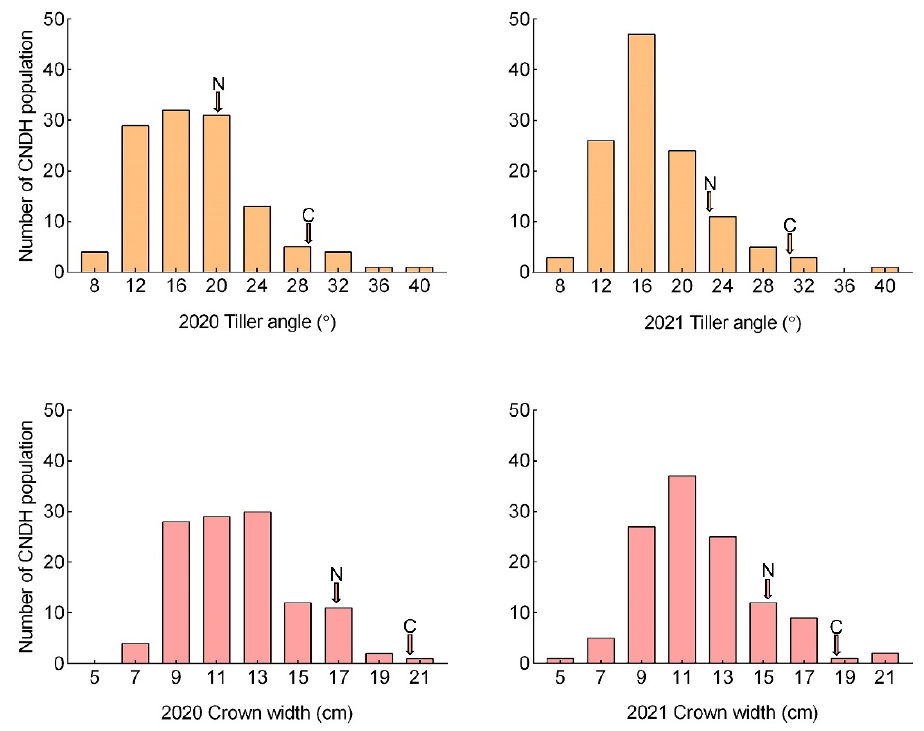
Figure 2. Frequency distribution of the tiller angle and tiller crown width in the CNDH population over two years for 2020 and 2021 (C, Cheongcheong; N, Nagdong). The tiller number and crown width show a normal distribution and are controlled by polygenes.